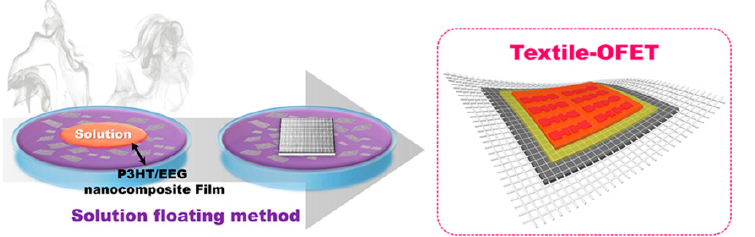
Figure 8. Schematic illustration of solution floating method for depositing the P3HT/EEG nanocom- posite film onto textile-OFET.